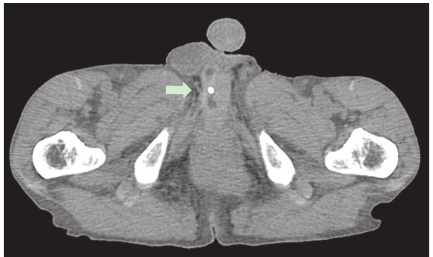
Figure 3: Calculus in the pendulous urethra on plain abdominal CT (arrow).